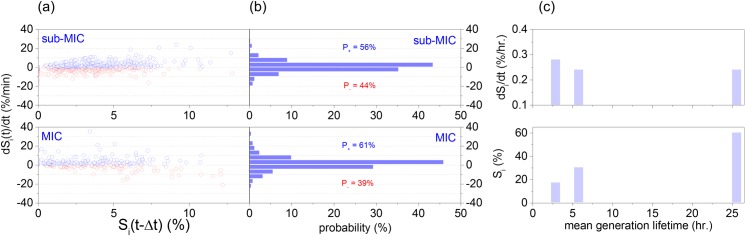
Similar to Fig 2, a scatter plot of the lipid flux (dSi/dt) as a function of the total lipid content (Si), and the associated probability histogram of the lipid flux for the sub-MIC (a) and for the MIC (b) concentration of CHX. (c) The dependence of the lipid content Si (in % per cell size by the 140th min. of observation) and the instantaneous lipid flux dSi/dt (%/hr) on the mean generation lifetime, controlled by different levels of CHX.